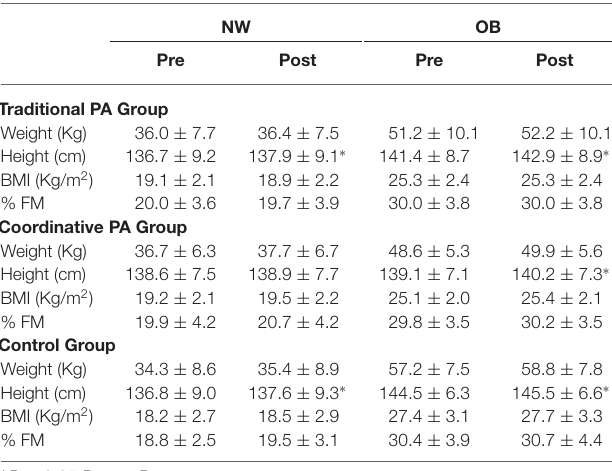
TABLE 1 | Pre- and post-intervention anthropometric characteristics of NW and OB children (mean values ± SD). NW OB Pre Post Pre Post